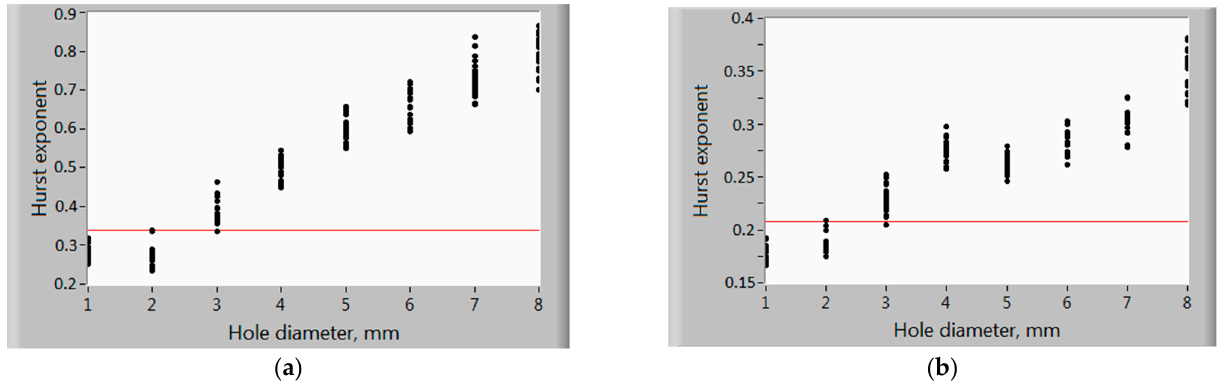
Figure 6. Values of the Hurst exponent at a pump discharge pressure of 1.5 bar: ( a ) for X-axis signals, ( b ) for Y-axis signals.